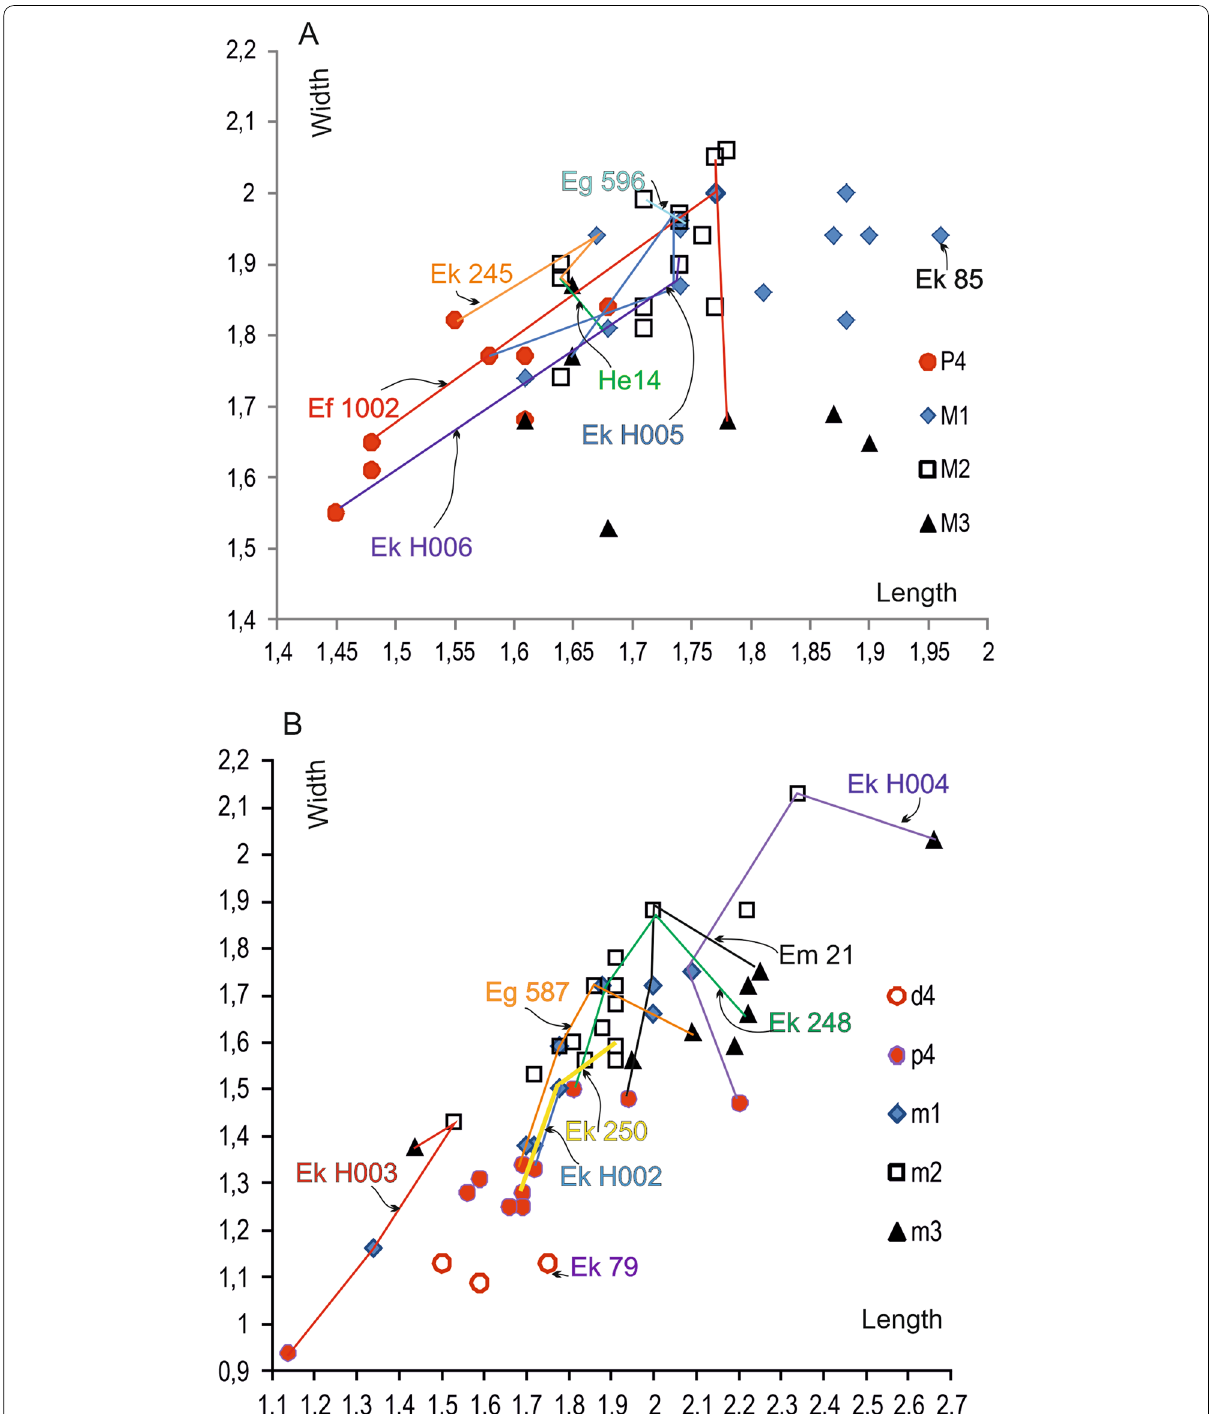
Fig. 3 Bivariate graph of the size (width/length) of the upper ( A ) and lower ( B ) teeth of the rodent’s species from Egerkingen (Swiss Jura). The colored lines joins the different loci on a same jaw. A upper teeth. Protadelomys cartieri (Stehlin & Schaub, 1951): Ef 1002, Holotype, P4 to M3, red line; Ek 245, M1 to M3, orange line; EK H006, P4 to M2, purple line; EK H005, M1 to M3, blue line; He 14, M1–M2, geen line; Eg 596, M1–M2, turquoise line. Homœtreposciurus egerkingensis nov. gen, nov. sp.: Ek 85, M1, black circle. B lower teeth. Protadelomys cartieri (Stehlin & Schaub, 1951): Ek H002, p4–m1, blue line;: Ek 250, p4–m2, yellow line; Ek 587, p4–m3, orange line; Ek 248, p4–m3, green line. Protadelomys lugdunensis Hartenberger, 1969: Em 21, p4 to m3. Homœtreposciurus egerkingensis nov. gen, nov. sp.: Ek H004, p4 to m3, purple line; Ek 79, dp4, purple circle. Eoelfomys nov. gen. nov. sp: Ek H003, p4 to m3, red